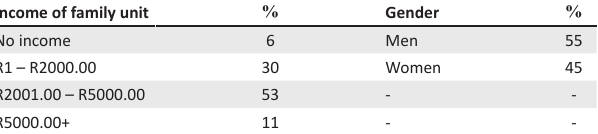
TABLE 1B: Demographic information of participants ( n = 53). (Percentages have been rounded).